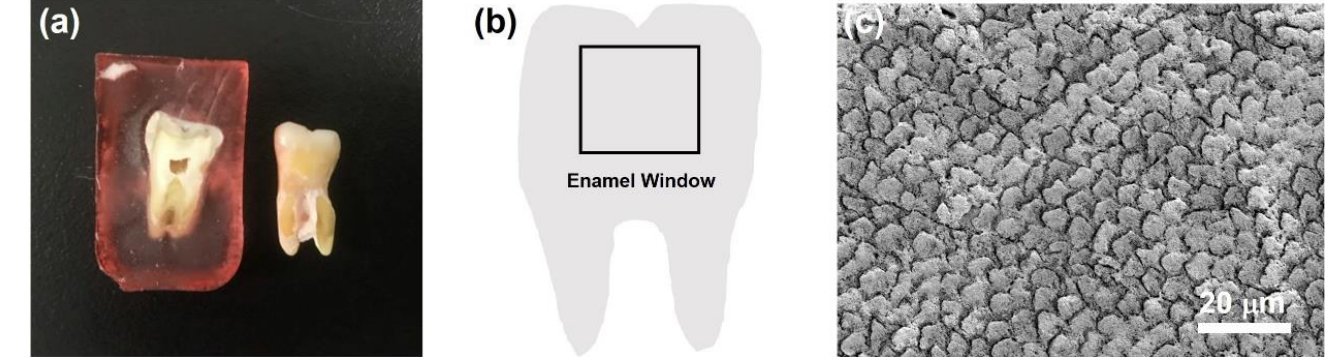
Figure 3. ( a ) Photo of tooth embedded in resin ( left ) and removed from the resin ( right ). ( b ) Illus-